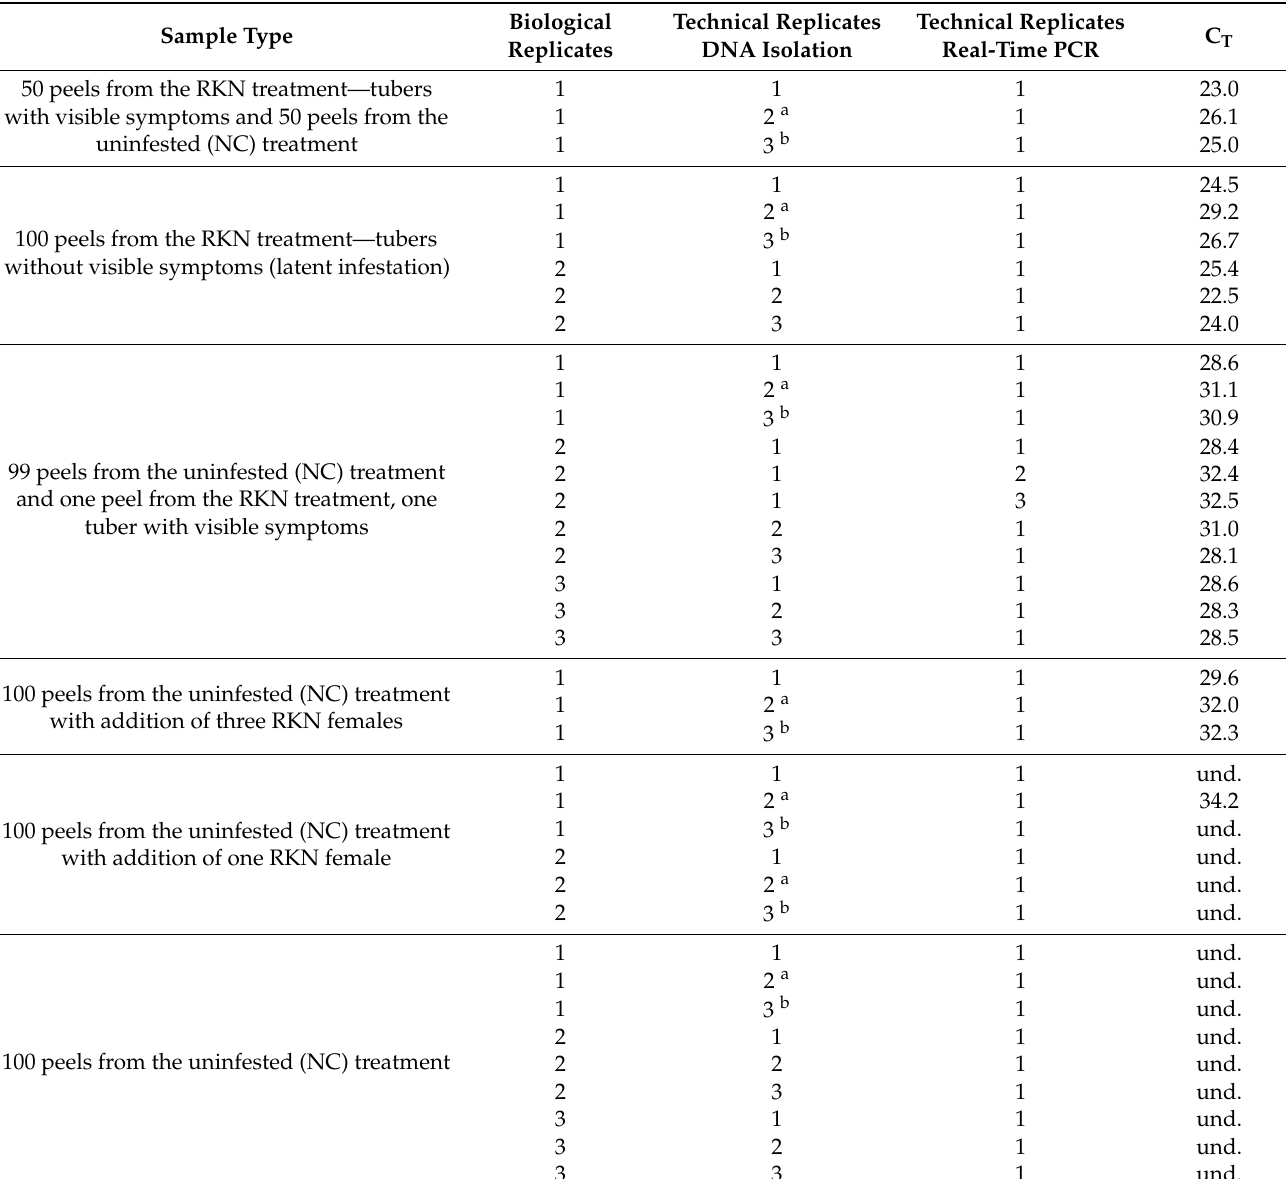
Table 1. Types of potato tuber samples with the number of biological and technical replicates processed to detect Meloidogyne luci infestation on potato tubers. All threshold cycle (C T ) values were obtained at the same C T threshold. Sample Type